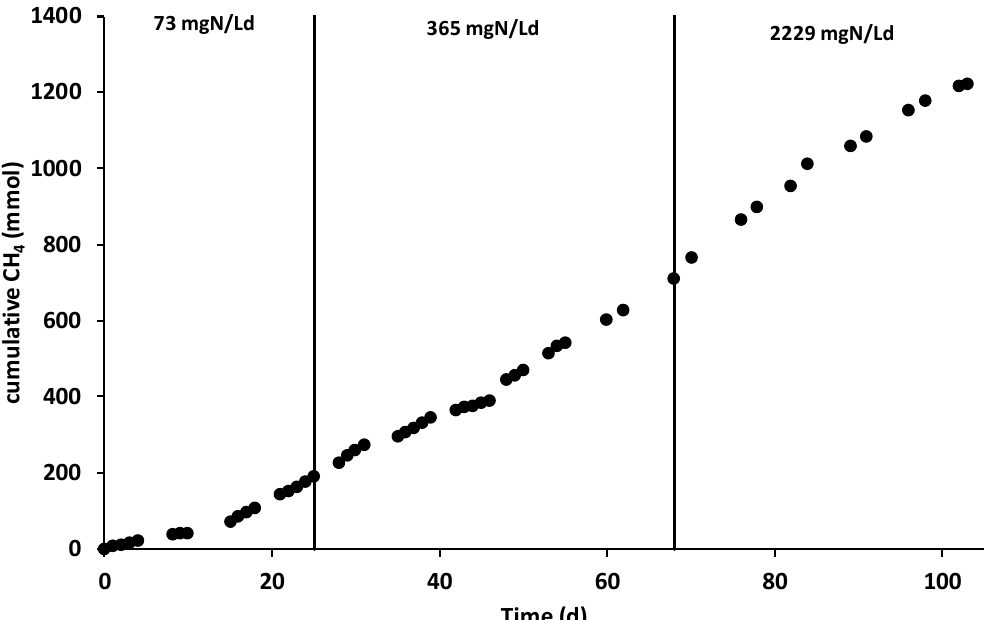
Figure 4. Cumulative methane production during the three different operating periods.